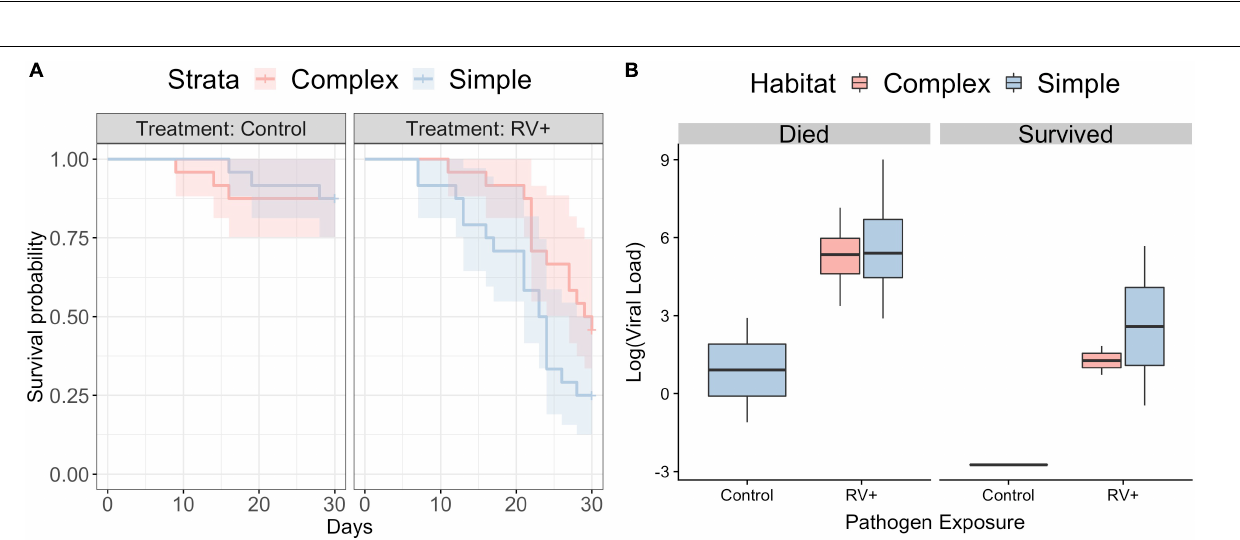
Frontiers in Microbiology |